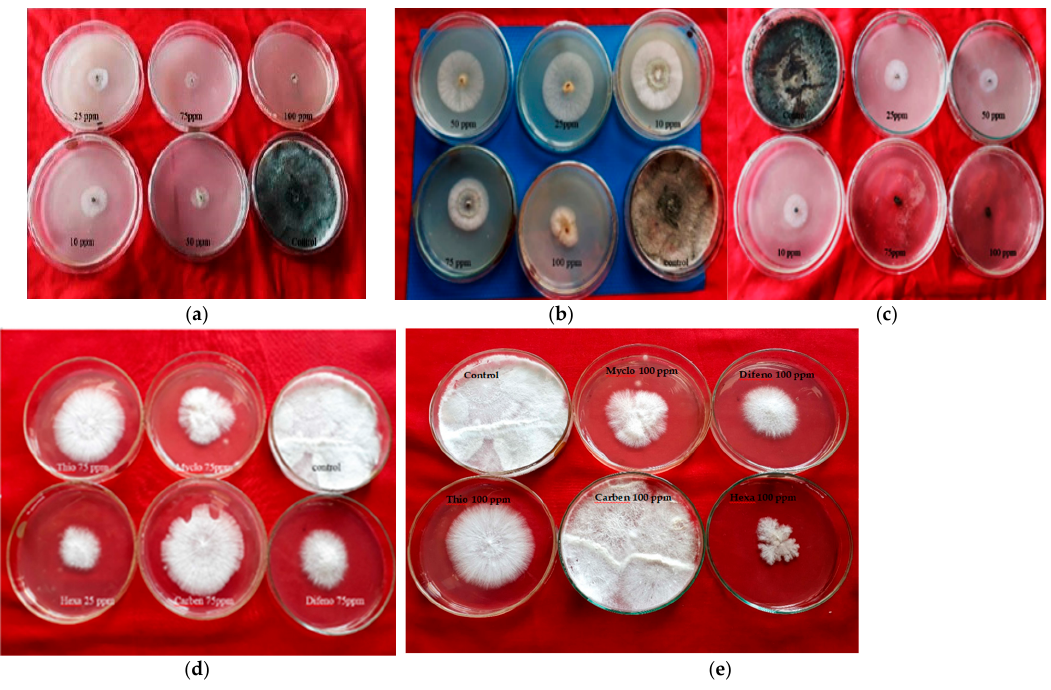
Figure 7. Effect of systemic fungitoxicants on radial mycelial growth of T. harzianum and A. bisporus : ( a ) thiophanate methyl against T. harzianum ; ( b ) myclobutanil against T. harzianum; ( c ) carbendazim against T. harzianum; ( d , e ) Thio (=thiophanate methyl), Myclo (=myclobutanil), Hexa (=hexacona- zole), Carben (=carbendazim) and Difeno (=difenoconazole) fungitoxicant against A. bisporus. 3.2.2. Effect of Systemic Fungitoxicants on Mycelial Growth of Pathogen ( T. harzianum )